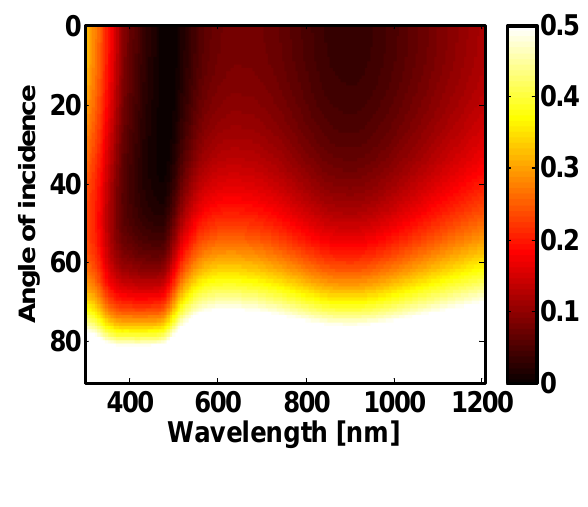
Figure 7. Angle dependent reflection from a silicon substrate that is covered with a dielectric spacer ( (cid:15) = 1 . 69 ) with a thickness of 70 nm and a layer made from a 20 nm thick gold nanocomposite. Colorbar in the figure is truncated to 0.5 to maintain